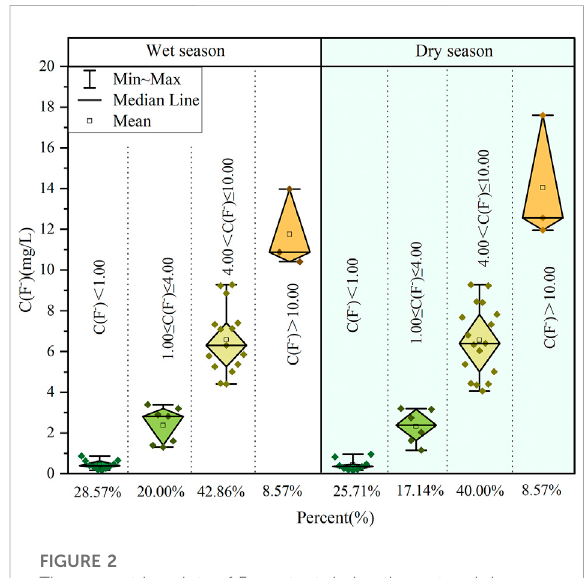
FIGURE 2 The percent boxplots of F - content during the wet and dry seasons.